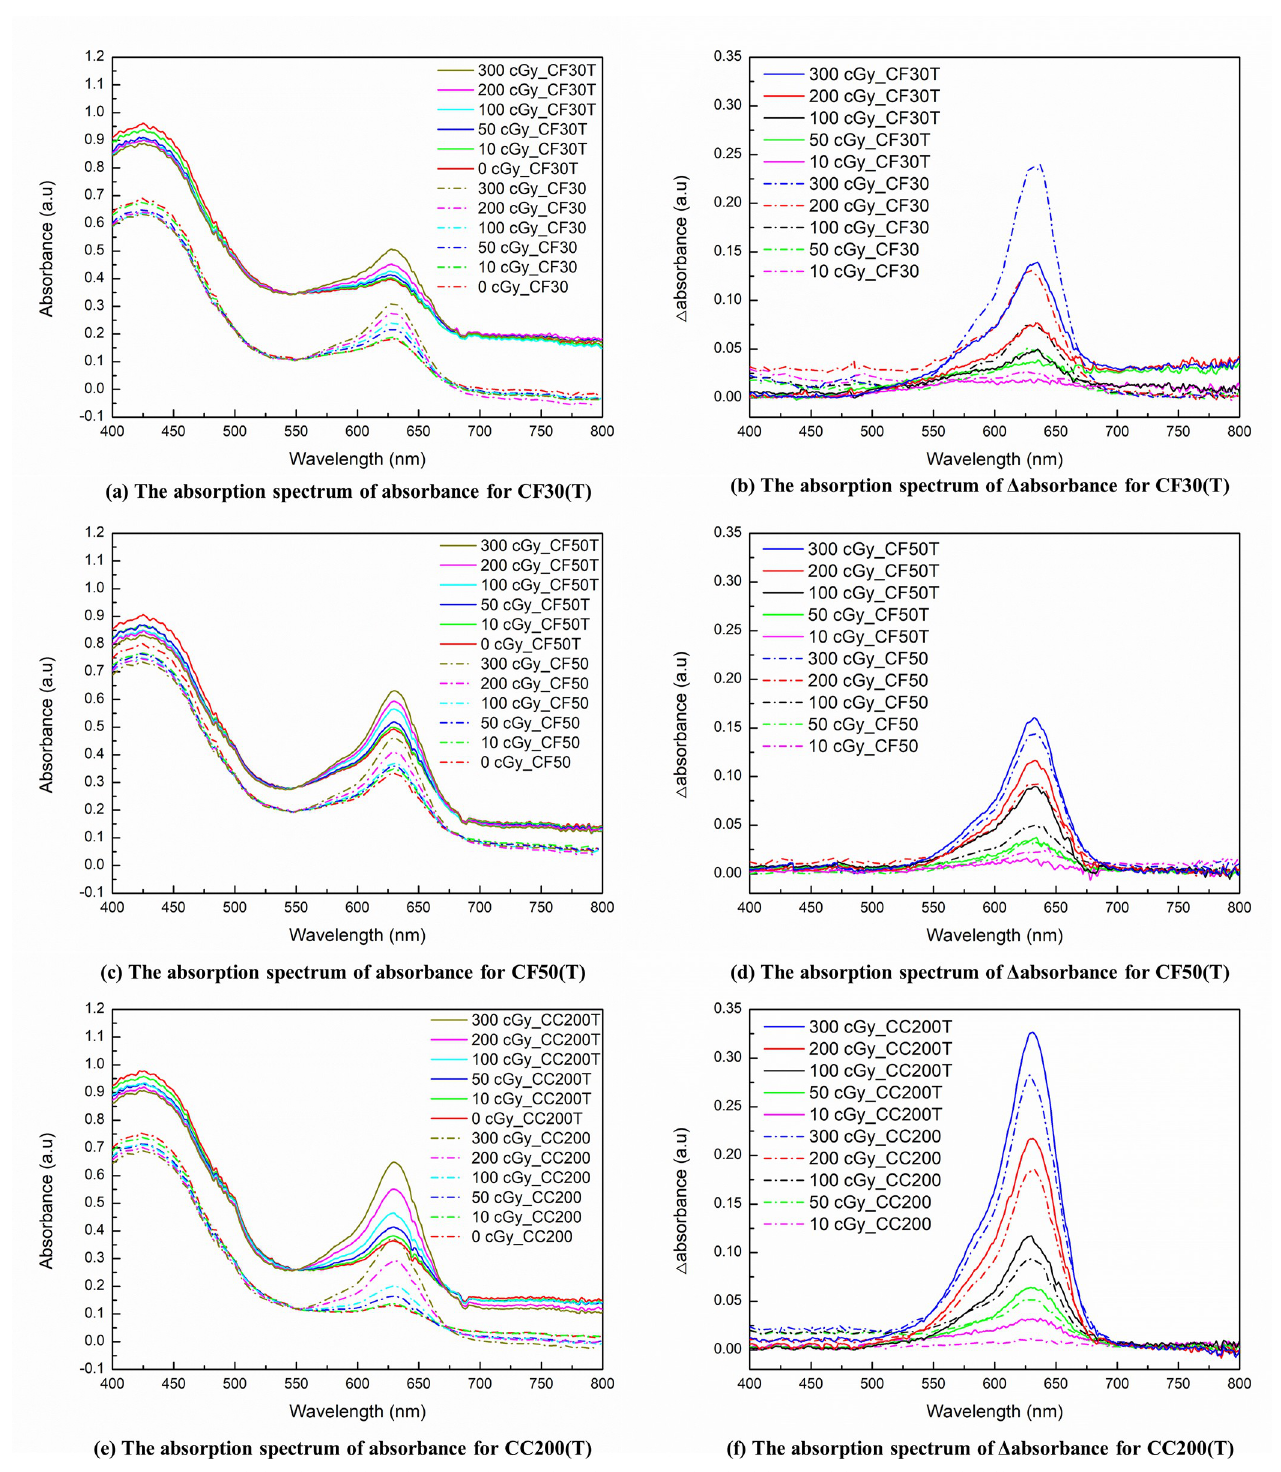
Fig 3. Representative optical absorbance plotted against the wavelength spectrum for the fabricated dosimeters with different irradiation doses and the wavelength spectrum of Δ absorbance acquired by subtracting the absorbance of the un-irradiated cuvette from that of the irradiated cuvettes. (a) The absorption spectrum of absorbance for CF30 and CF30T formulations refer to polyurethane Clear Flex ™ 30. (b) The absorption spectrum of Δ absorbance for CF30 and CF30T. (c) The absorption spectrum of absorbance for CF50 and CF50T formulations refer to polyurethane Clear Flex ™ 50. (d) The absorption spectrum of Δ absorbance for CF50 and CF50T. (e) The absorption spectrum of absorbance for CC200 and CC200T formulations refer to polyurethane Crystal